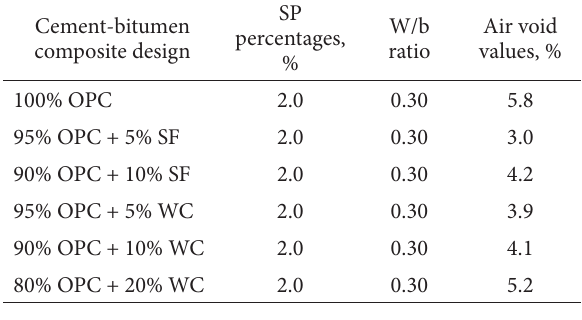
Table 4. Air void values of cement-bitumen composites Cement-bitumen composite design